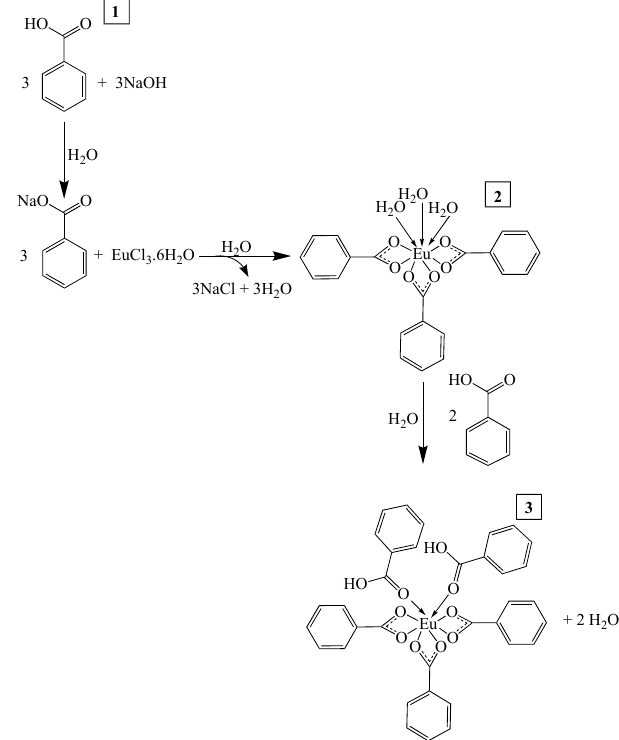
Figure 2. Synthesis of 2 : [Eu(OOCC 6 H 5 ) 3 ·(H 2 O) 3 ] and 3 : [Eu(OOCC 6 H 5 ) 3 ·(HOOCC 6 H 5 ) 2 ]. In both complexes, the oxidation state of europium is 3+.